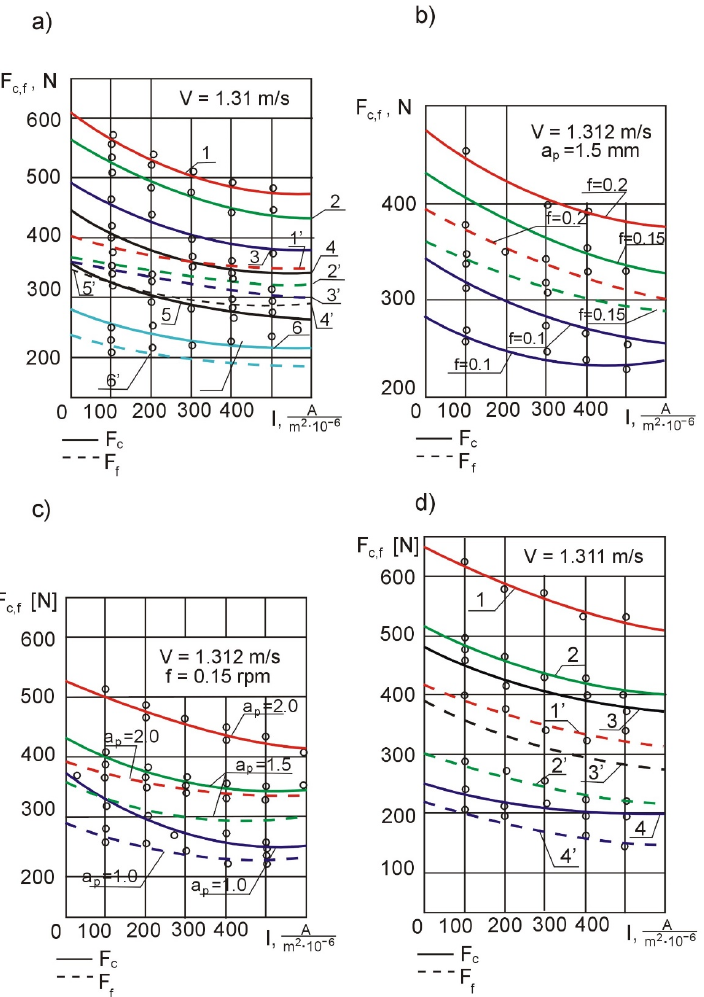
Figure 7. Effect of current density on cutting forces in the operation of turning Grade 2 alloy: f = 0.2 · 10 − 3 m/rev , a p = 2 · 10 − 3 m (1–1’) , f = 0.15 · 10 − 3 m/rev , a p = 2 · 10 − 3 m (2–2’), f = 0.2 · 10 − 3 m/rev , a p = 1.5 · 10 − 3 m (3–3’), f = 0.1 · 10 − 3 m/rev , a p = 1.5 · 10 − 3 m (4–4’), f = 0.1 · 10 − 3 m/rev , a p = 2 · 10 − 3 m (5–5’), f = 0.1 · 10 − 3 m/rev , a p = 1.5 · 10 − 3 m (6–6’)—( a ); curves of changes in cutting forces generated during turning of Ti- 64 for different feed rates—( b ); curves of changes in cutting forces generated during turning of Ti- 64 for different depths of cut—( c ); cutting force curves for the Ti-64 boring operation: f = 0.212 · 10 − 3 m/rev , a p = 1.5 · 10 − 3 m (1–1’) , f = 0.15 · 10 − 3 m/rev , a p = 1 · 10 − 3 m (2–2’), f = 0.15 · 10 − 3 m/rev , a p = 0.75 · 10 − 3 m (3–3’), a p = 1.5 · 10 − 3 m (4–4’)—( d ).